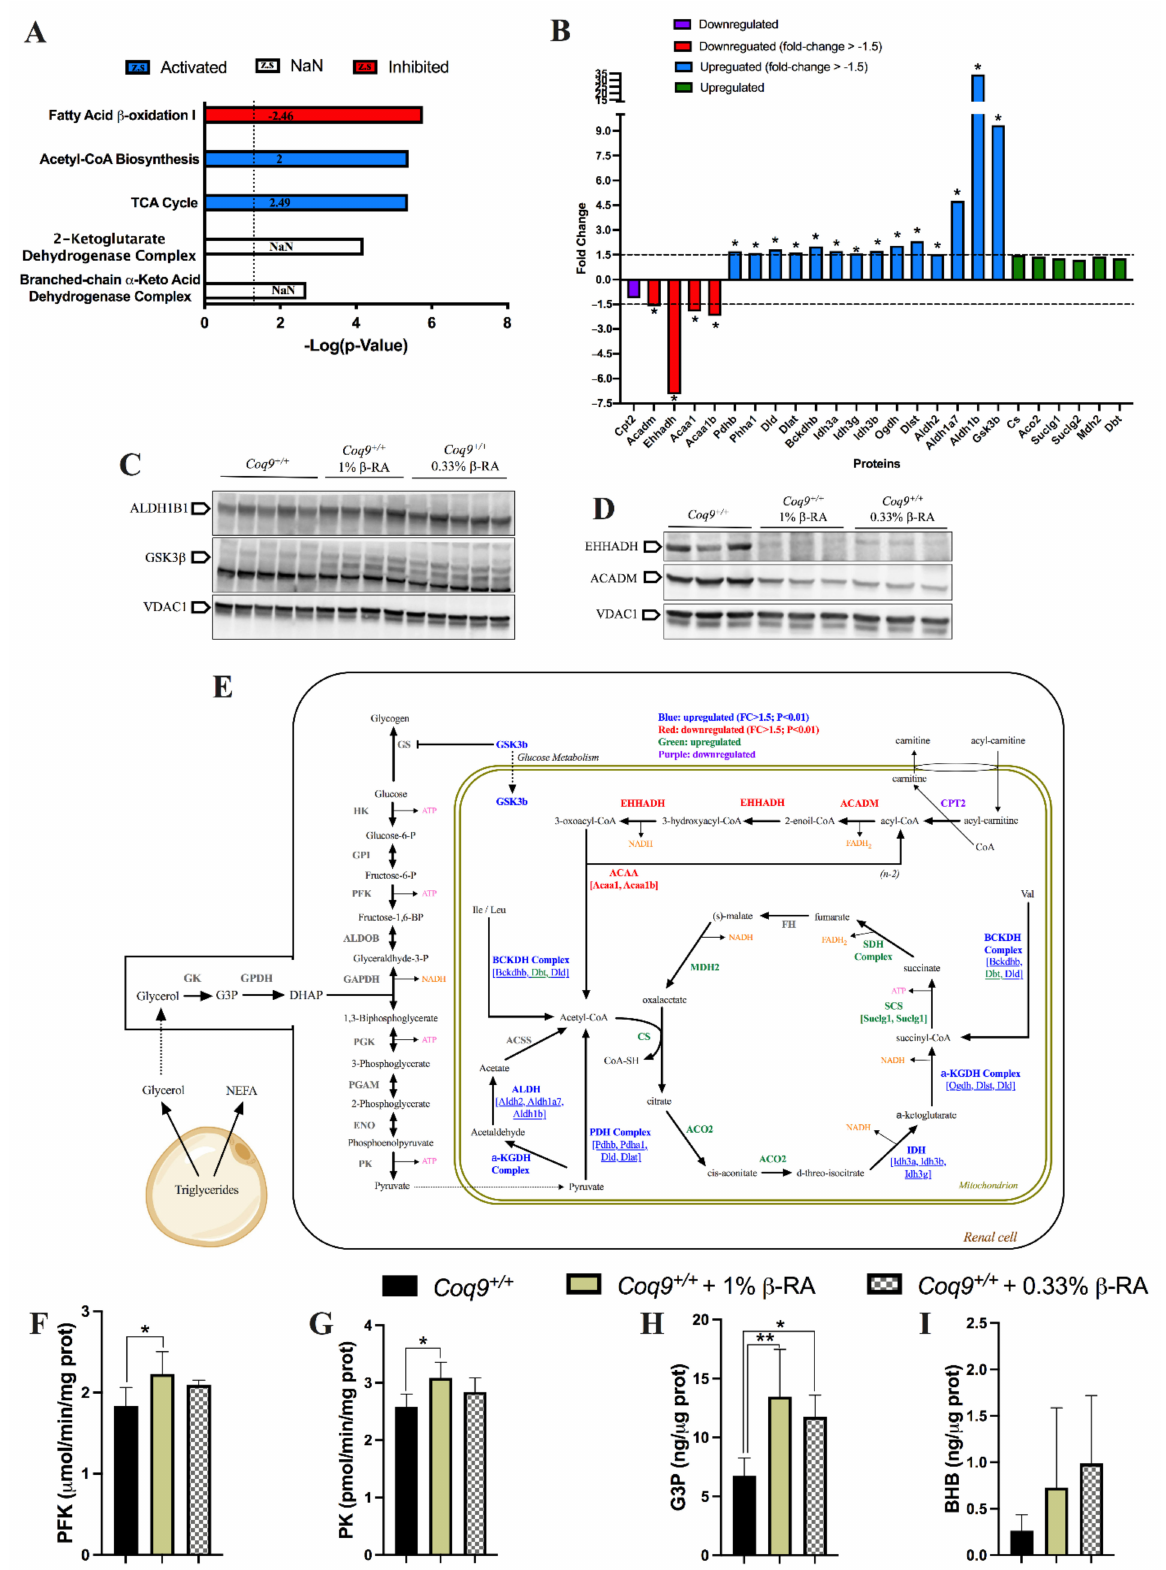
Figure 5. Adaptation of the mitochondrial proteome to the treatment with β -RA in the kidneys of the Coq9 +/+ mice. ( A ) Top enriched metabolic canonical pathways in the renal mitochondrial proteome from the Coq9 +/+ mice after two months of 1% β -RA supplementation. Dotted line: Adjusted p = 0.05. Blue signifies that the category was expected to be activated according to the z-score; red signifies that the category was expected to be inhibited according to the z-score. ( B ) Fold